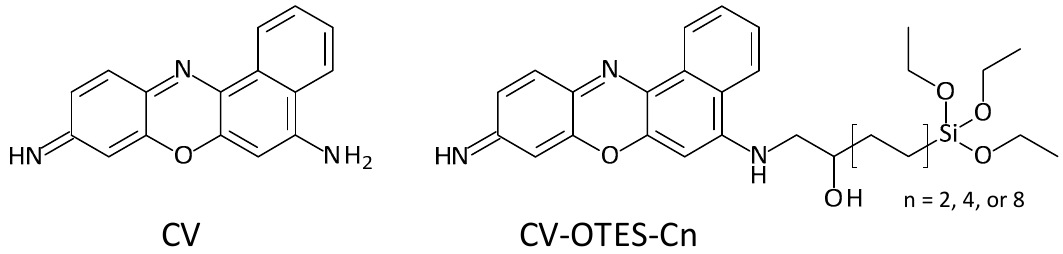
Figure 1. Chemical structures of cresyl violet (9-iminobenzo[a]phenoxazin-5-amine; CV) and CV– OTES–Cn. For the chemical structures of OTES–Cn, see Figure S1.